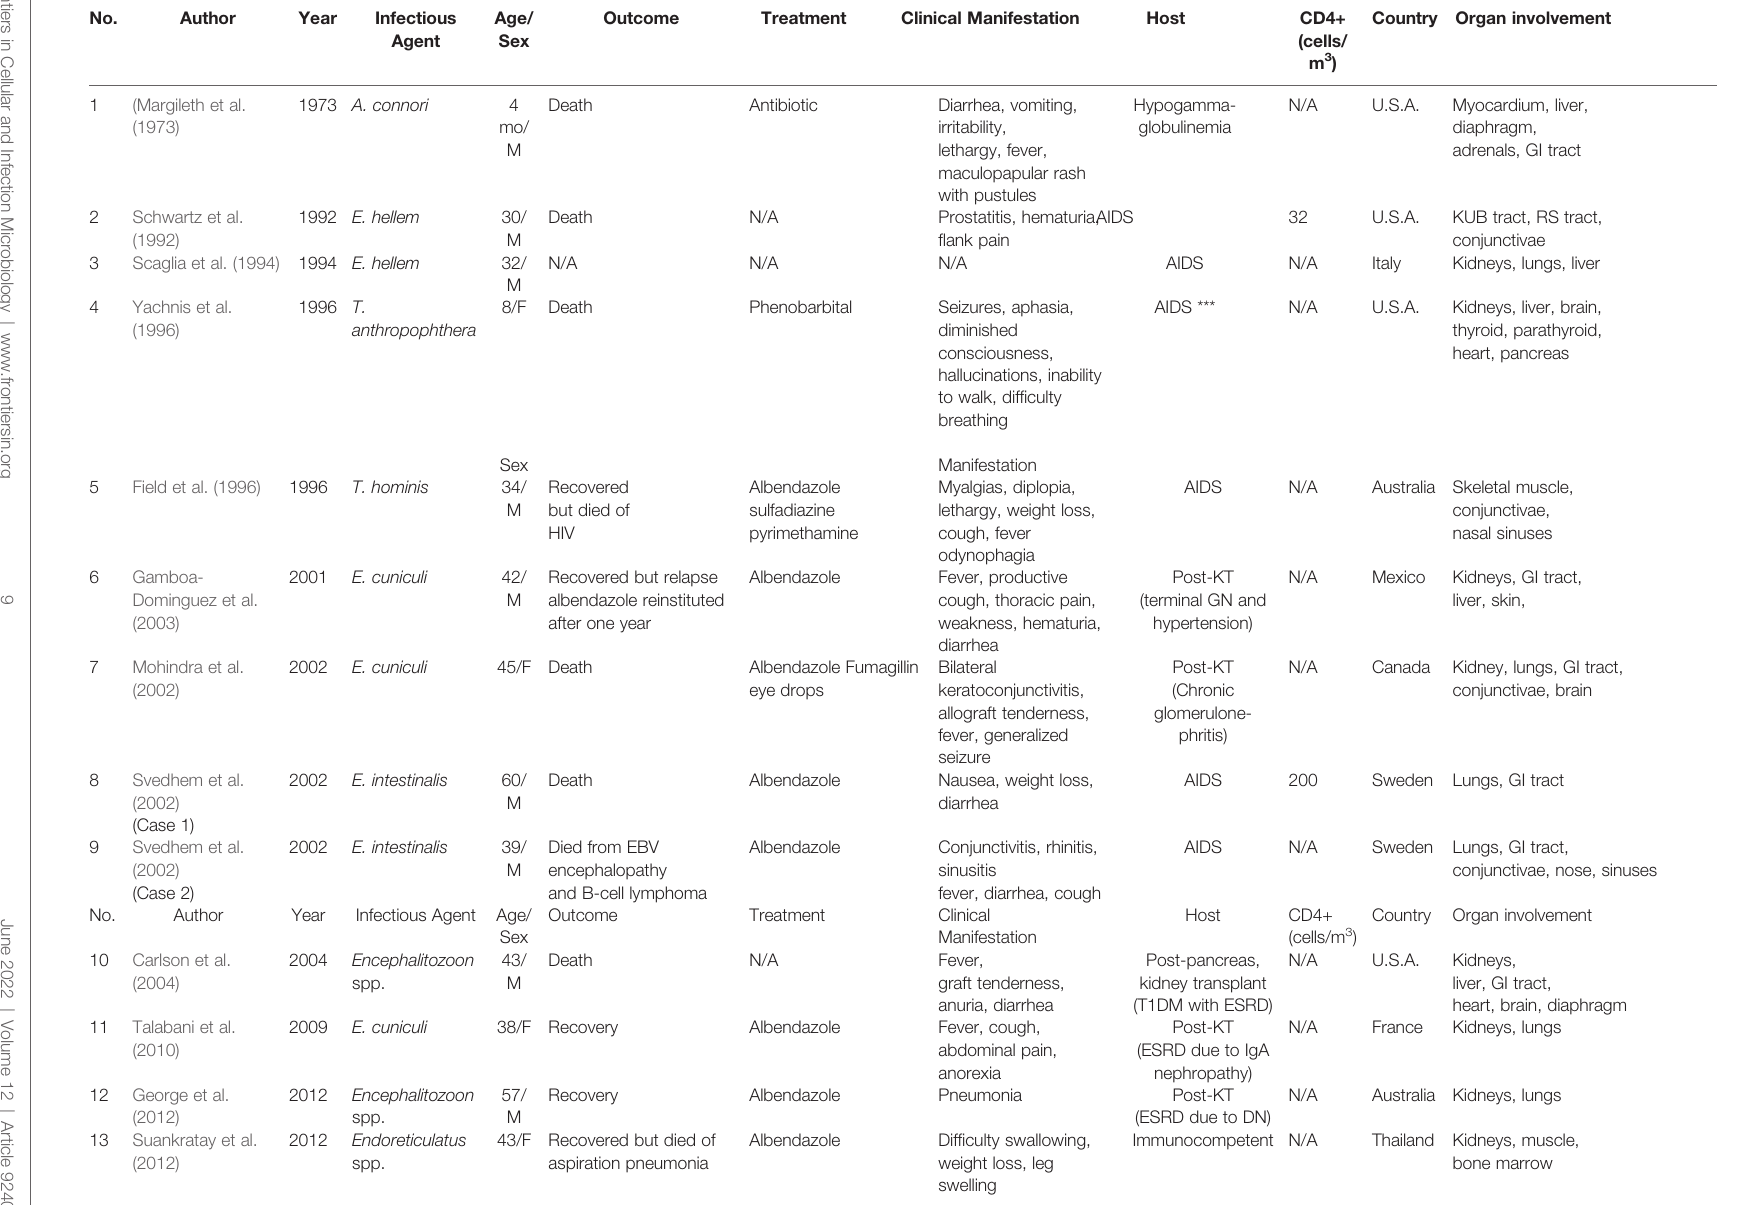
TABLE 2 | Disseminated microsporidiosis